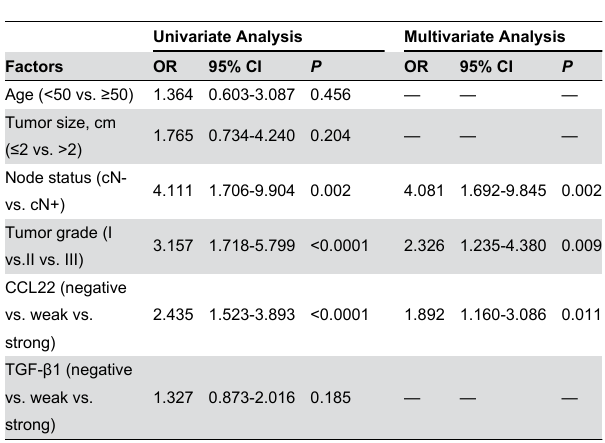
Table 5. Univariate and multivariate analyses (logistic regression) of pathological features and cytokines for OS in BC.